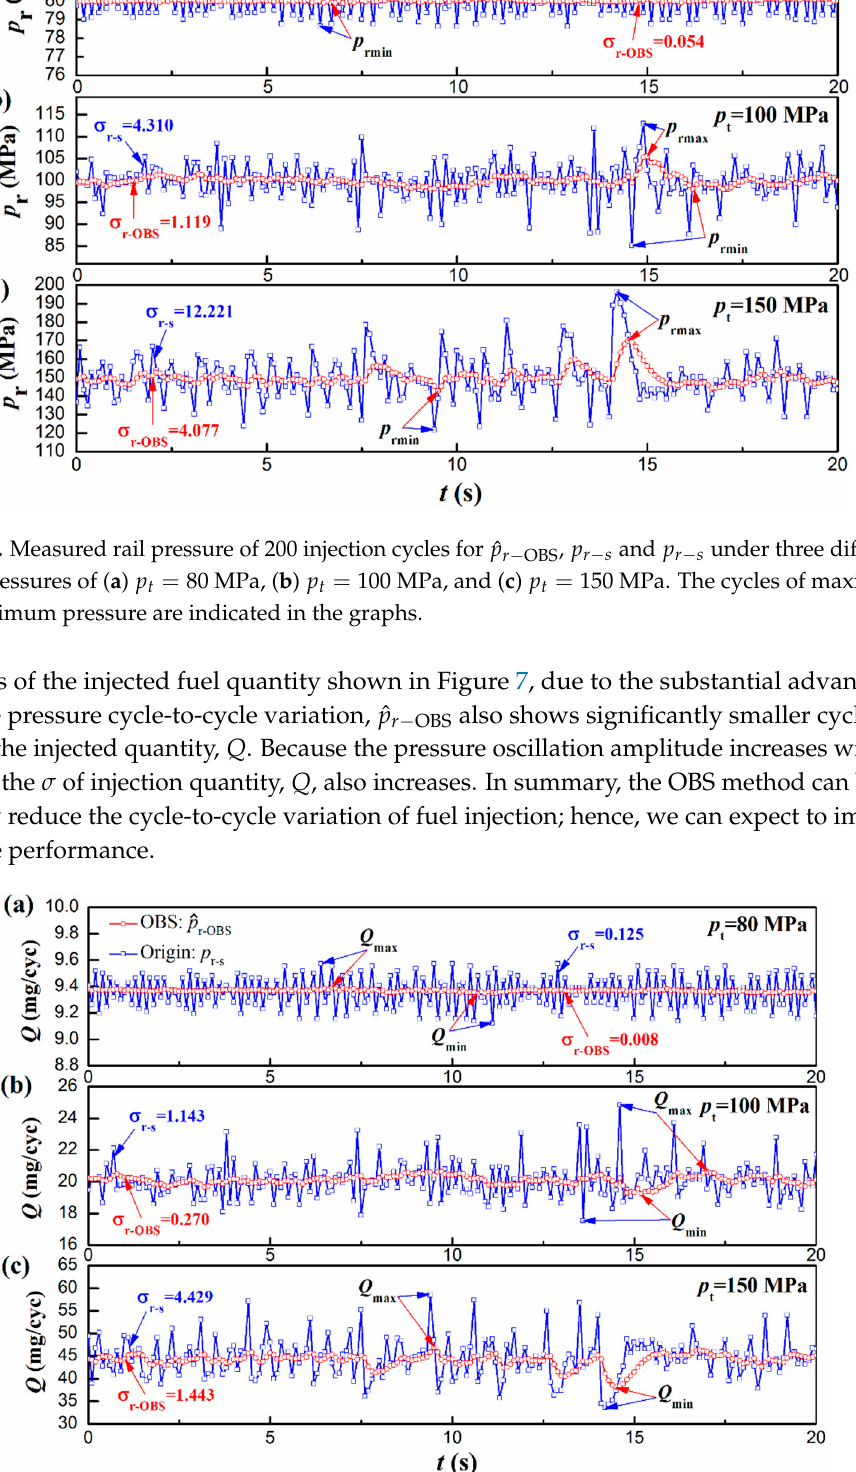
and (cid:1868) under three different (cid:3045)-(cid:2899)(cid:2886)(cid:2903) (cid:3045)-(cid:3046)